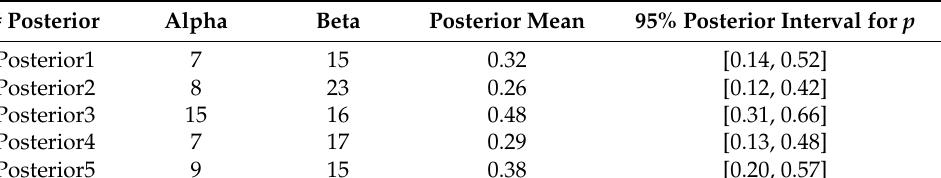
Table 4. Parameters of each posterior distribution for the second application (sample with n = 20, k = 6).